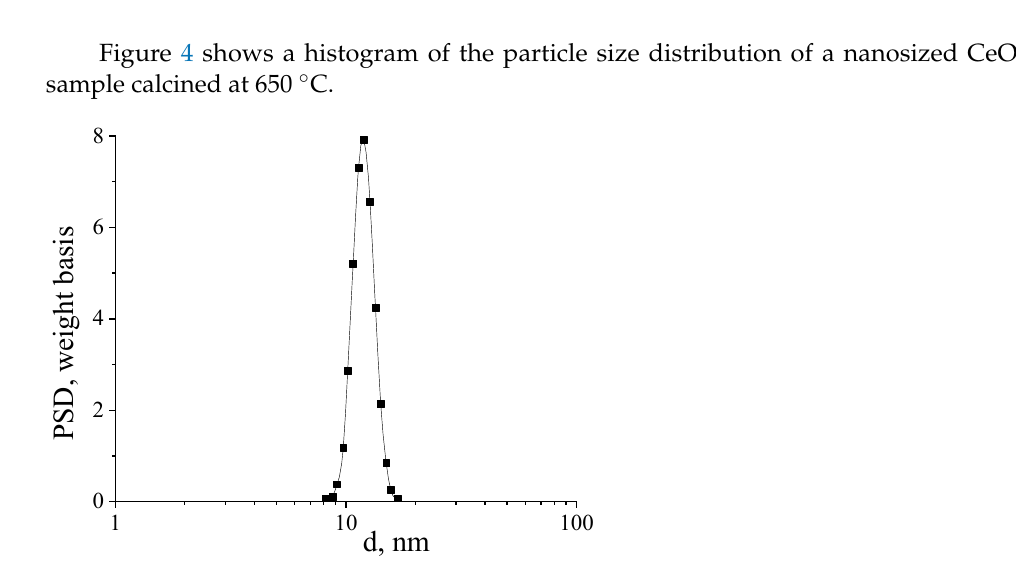
Figure 3. SEM micrographs of the CeO 2 -Ag4 sample: ( a ) 128,000-fold magni fi cation; ( b ) 25,600-fold